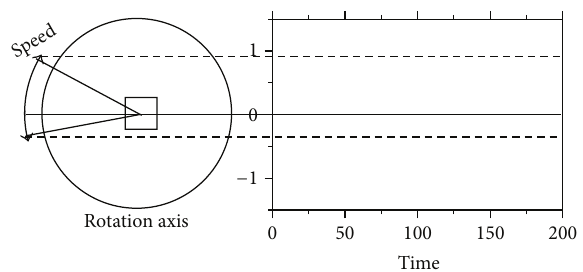
Figure 1: The relation between the angular velocity and the value of an oscillator.